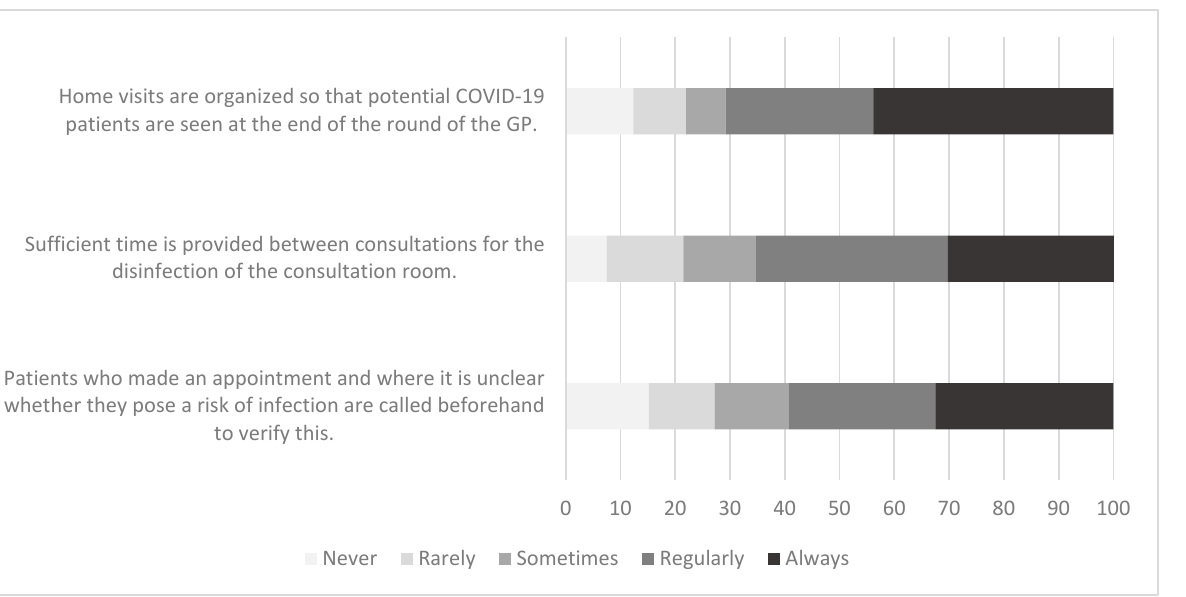
Figure 1. Patient flow arrangements.